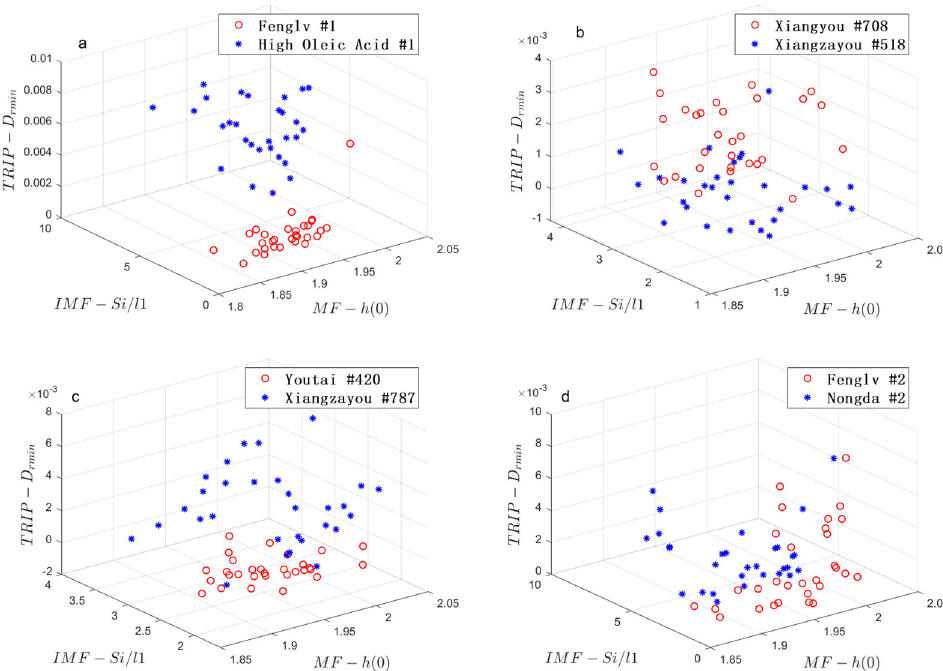
Figure 3. Visualization of two tree species in the {MF ‐ ℎ(cid:4666) 0 (cid:4667) , IMF ‐ 𝑆𝑖 / 𝐼 1 , TRIP ‐ 𝐷 (cid:3045)(cid:3040)(cid:3036)(cid:3041) } space. ( a ) Fenglv 1 versus to High Oleic Acid #1; ( b ) Xiangyou #708 versus to Xiangzayou #518; ( c ) Youtai #420 versus to Xiangzayou #787; ( d ) Fenglv #2 versus to Nongda #2.